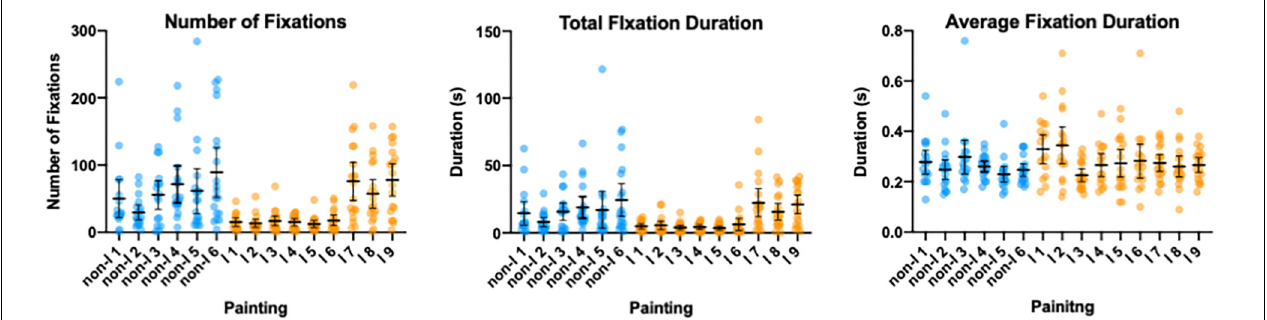
FIGURE 7 | Number of fixations (left panel) , total fixation duration (middle panel) and average fixation duration (left panel) shown per each painting. Each dot represents data from one participant with the mean with 95%CI for each painting superimposed in black color. The data corresponding to the non-Indigenous and Indigenous paintings shown in blue and orange color, respectively. The paintings in each group are ordered from the smallest to the largest in area for that group. The error bars represent 95% CI.